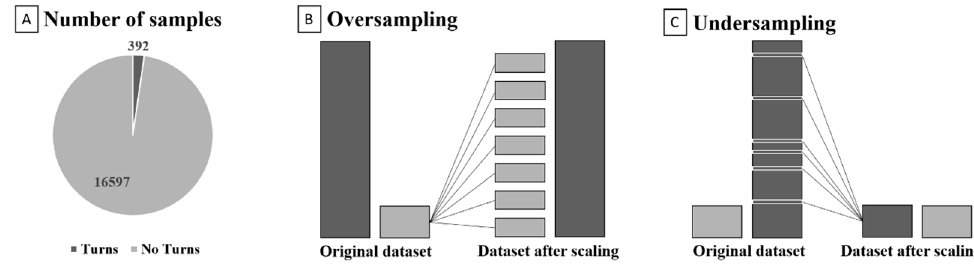
Figure 6. Imbalanced sample problem: ( A ) Graph describing comparison of classes occurrences in the considered sample; ( B ) Visualization of oversampling method; ( C ) Visualization of the undersampling method.